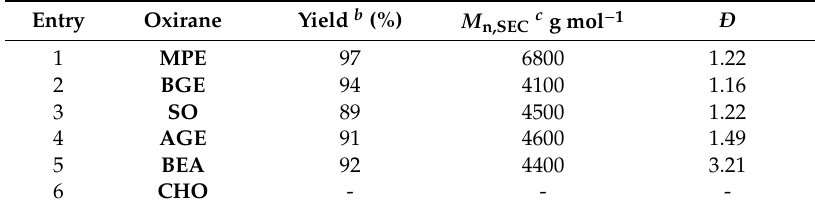
Table 2. Copolymerization of various oxiranes with SBL a